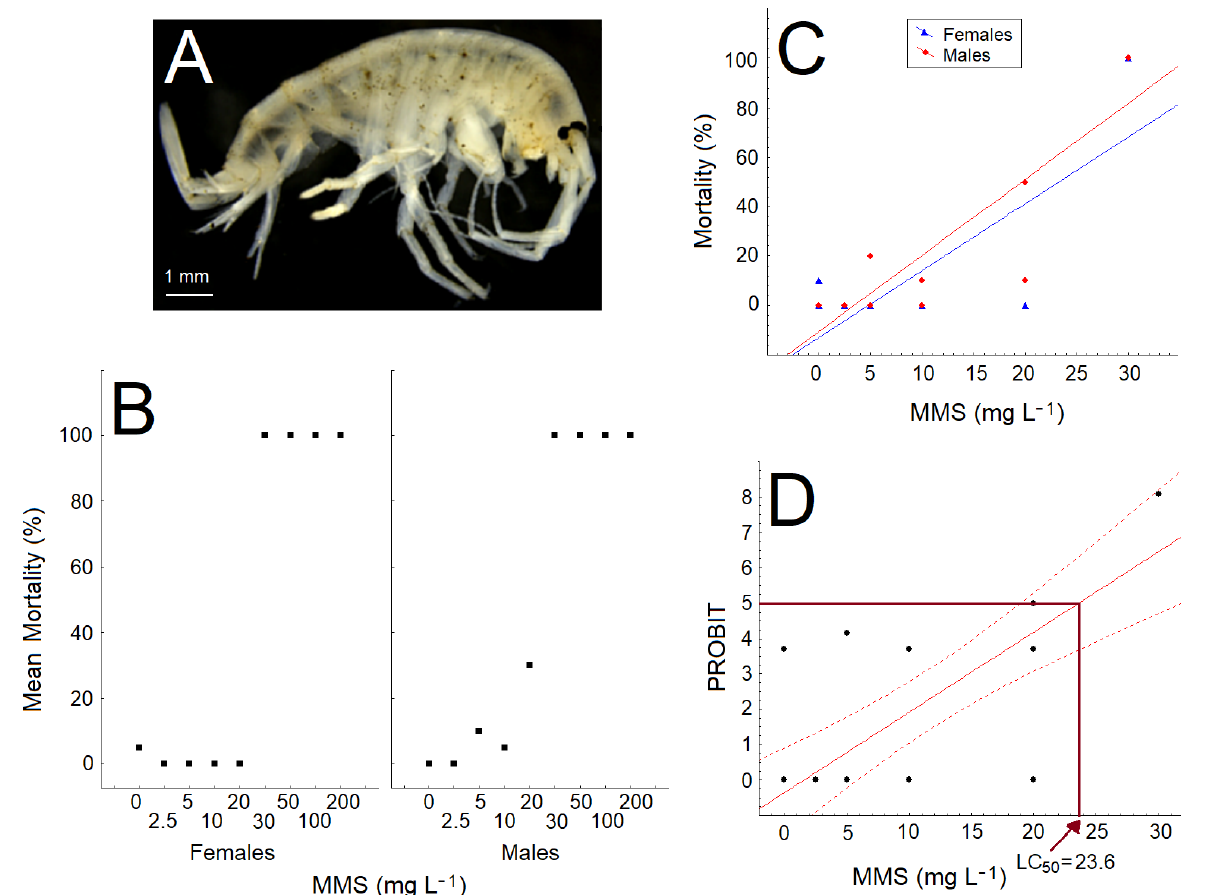
Figure 1. (A) The amphipod Quadrivisio lutzi (Schoemaker, 1933); (B) Average mortality of male and female amphipods Q. lutzi after 48 h of exposure to different MMS concentrations; (C) Regression lines that associate male and female average mortality with MMS concentrations; (D) Regression line that associates PROBIT values with MMS concentrations and extrapolation of the median lethal concentration for Q. lutzi from PROBIT 5 to MMS